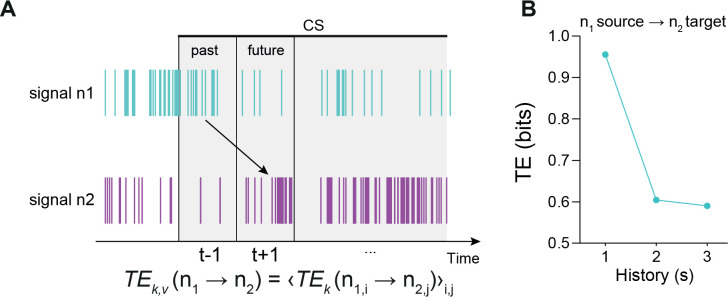
Illustration for quantifying TE and assessment of TE parameter space.(A) Principle of the quantification of TE between neuron n1 and neuron n2, where k refers to past states and i and j label the sample subset of n1,i and n2,j of size v in each region. n2 future signal (time = t+1) can be predicted from the pattern of past activity (time = t-1) in n1. (B) Mean TE between all pairs of neurons for each CS-type and stage (RC, FC, recall), calculated for the entire network for 1 s binned data with history windows of 1, 2, or 3 s.